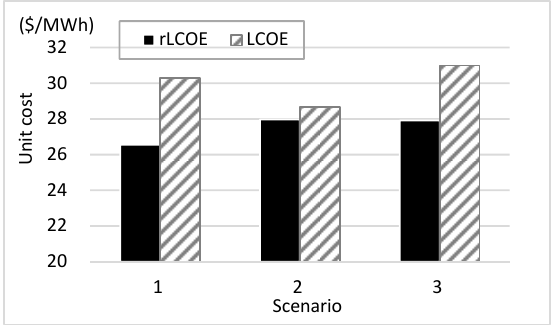
Figure 7. rLCOE and LCOE results in each scenario